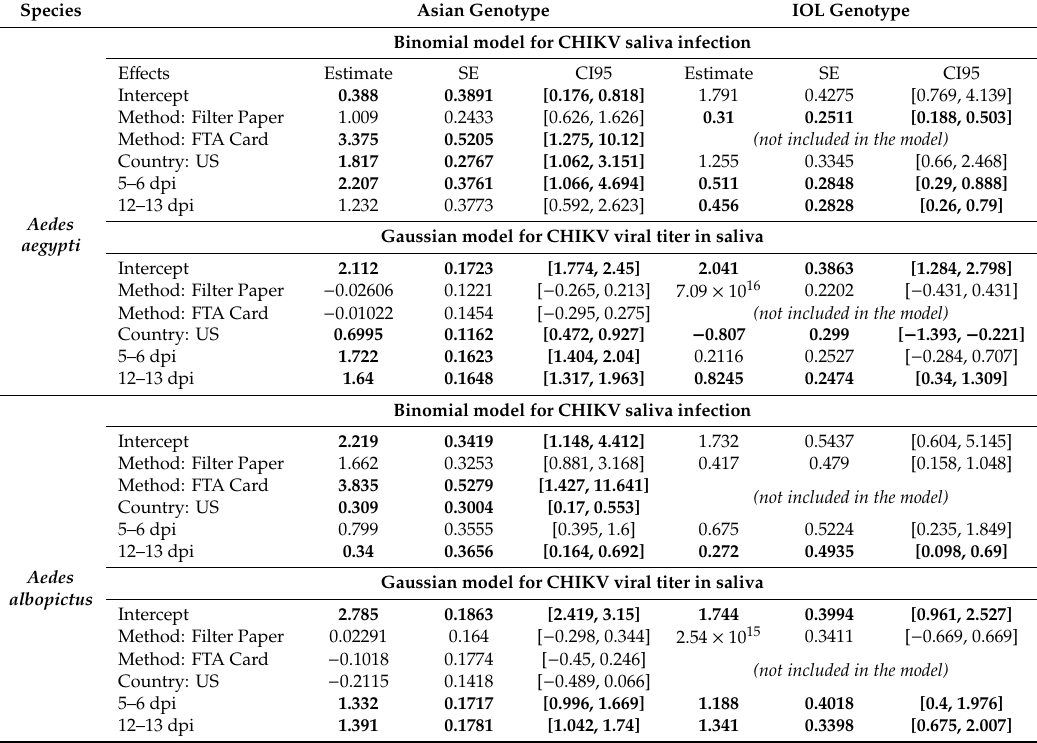
Table 3. Estimated e ff ects and 95% confidence interval of detection method, country of origin, and days post-infection for the Asian and IOL CHIKV genotypes for both Ae. aegypti and Ae. albopictus , as measured by in the binomial and Gaussian generalized linear